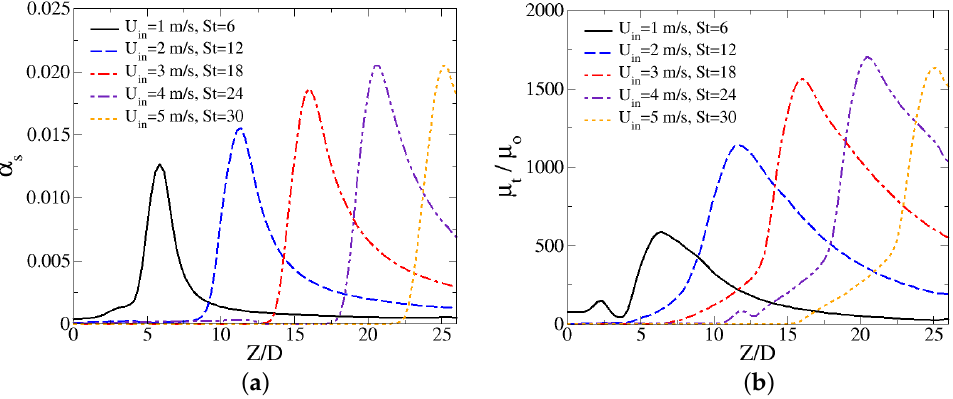
Figure 10. Predicted solid volume fraction ( a ) and turbulent viscosity ratio ( b ) profiles along Z / D near the